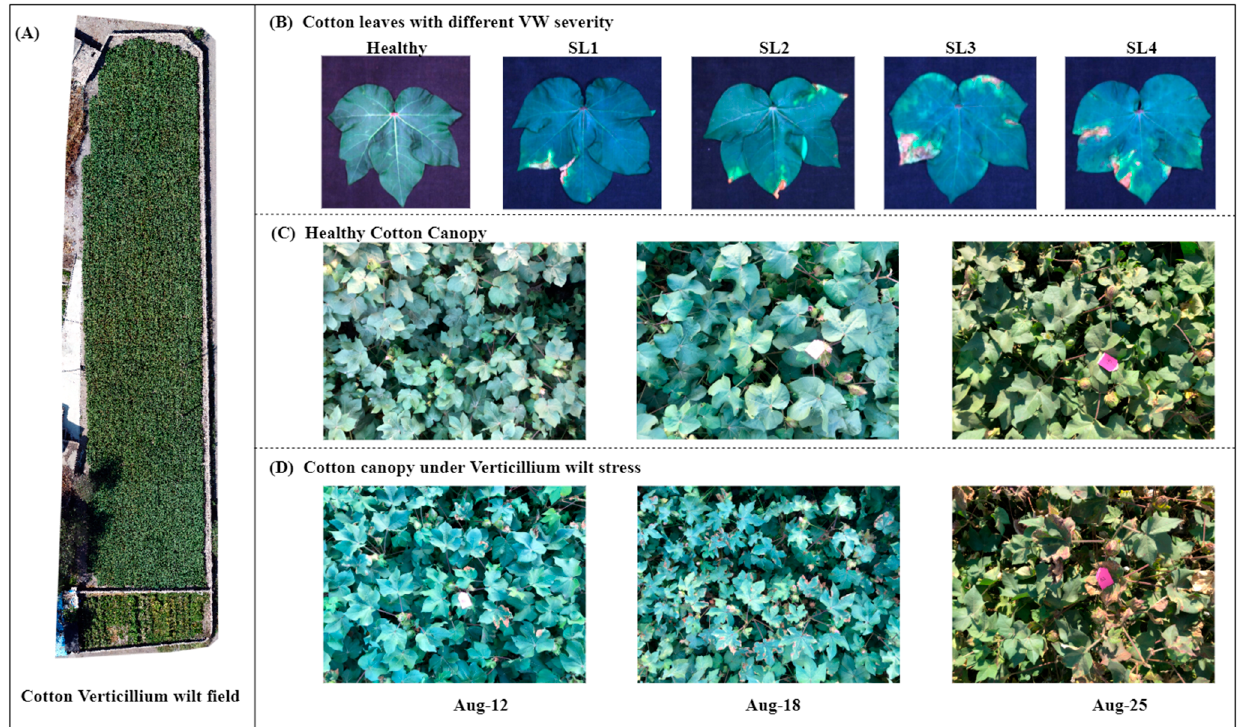
Figure 1. Cotton verticillium wilt (VW) disease field. ( A ) Diseased field, ( B ) healthy cotton leaves and leaves with four VW severities (SL1–SL4 being classified according to a 10% increase in severity of the disease spots), ( C , D ) cotton canopies for three periods (on 12, 18, and 25 August 2021), from healthy to VW stress. Table 1. Classification of disease